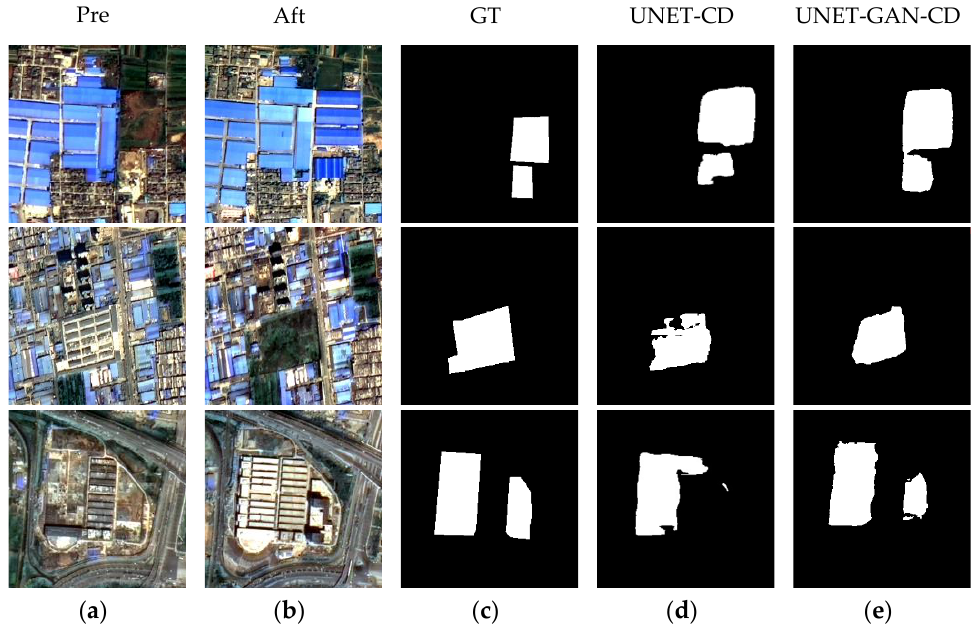
Figure 15. Sub-region change detection results on XI’AN-CDD: ( a ) image before the change, ( b ) image after the change, ( c ) ground truth, ( d ) detection results of UNET-CD, and ( e ) detection results of UNET-GAN-CD.